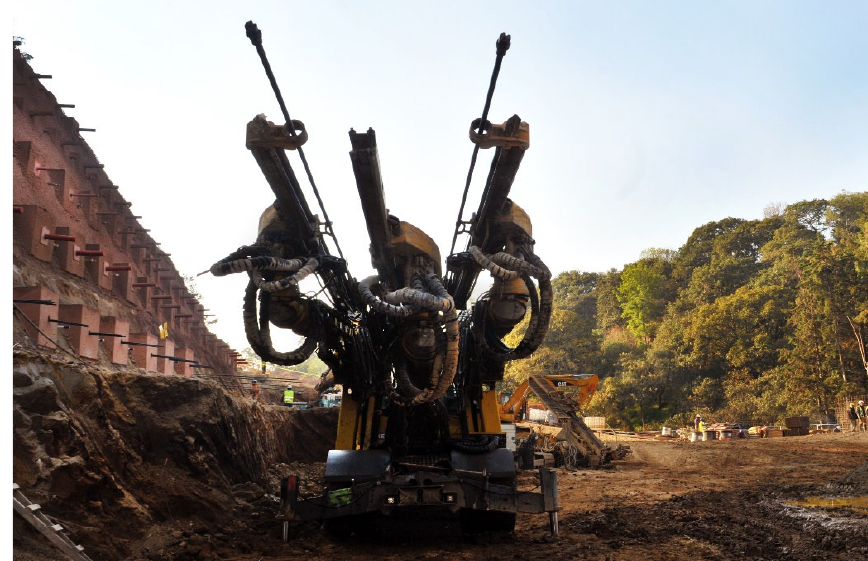
Figure 3. Jumbo with three drilling arms.